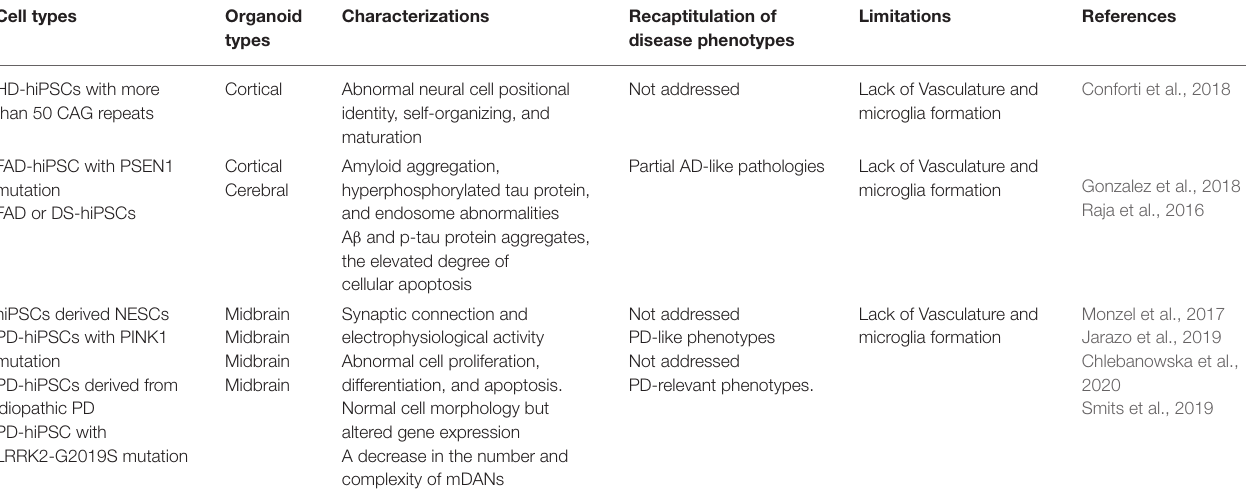
TABLE 4 | Modeling neurodegenerative diseases in hiPSC-derived